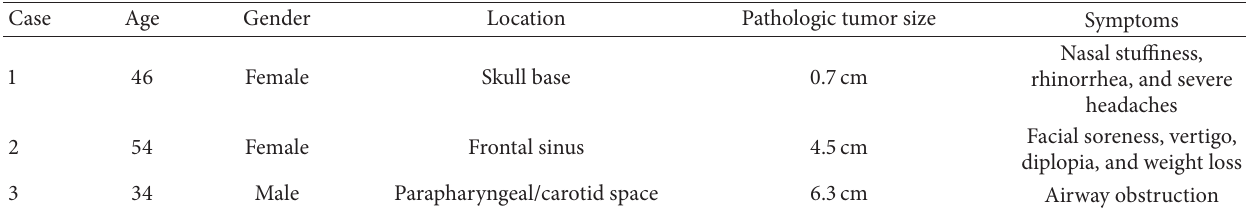
Table 1: Clinical characteristics of the MPNST series.